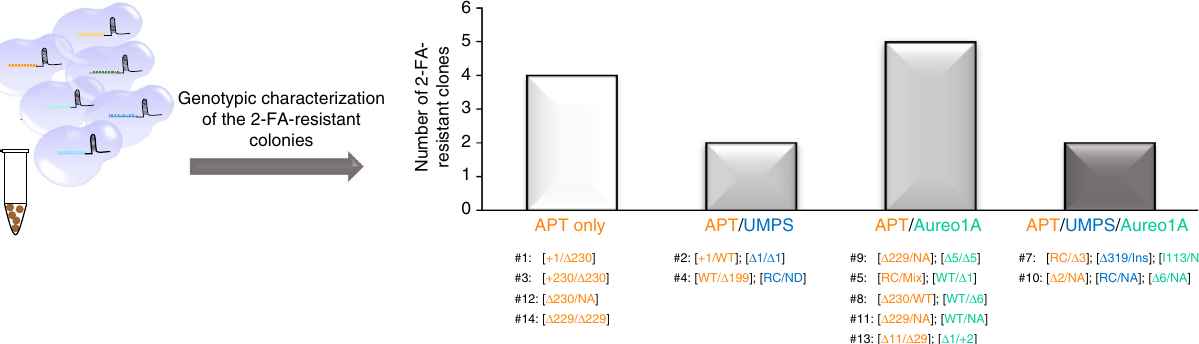
Fig. 5 One-step generation of triple knock-out strains. WT Phaeodactylum cells were simultaneously bombarded with six RNP complexes, each directed against one speci fi c target at either the PtAPT , PtUMPS , or PtAureo1a loci. After two days, cultures were transferred onto 2-FA selective medium supplemented with adenine and uracil. Fourteen 2-FA resistant clones (referred to as strains AUA#1 to #14) were obtained and screened for the presence of mutagenic events at the six target sites. Bar plots present the number of 2-FA resistant colonies harboring mutations at the PtAPT loci only (white bar), at both the PtAPT and PtUMPS loci or the PtAPT and PtAureo1a loci (light gray bars), or at all three loci (dark gray bar). The genotypes of the corresponding clones are presented underneath the graph and written in orange font for PtAPT , blue for PtUMPS and green for PtAureo1a . RC reverse complement insertion. NA not ampli fi able, Mix mosaic, ND not